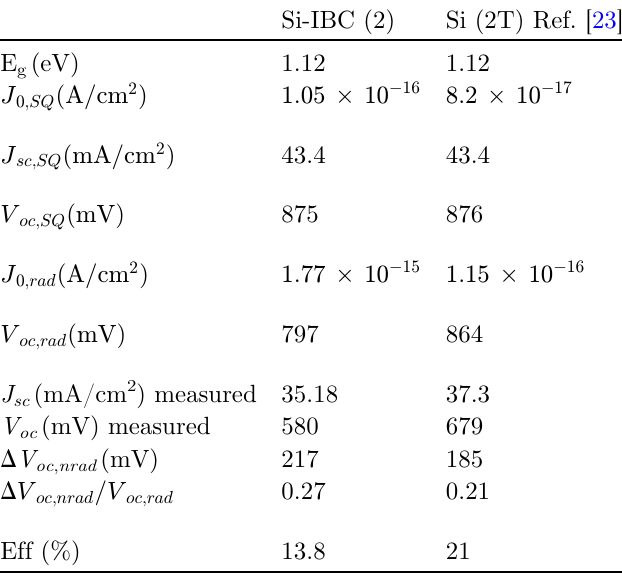
and interfaces, the non-radiative recombination is domi- nated by Shockley-Read-Hall (SRH) recombination via defect levels in the bandgap of the silicon semiconductor.